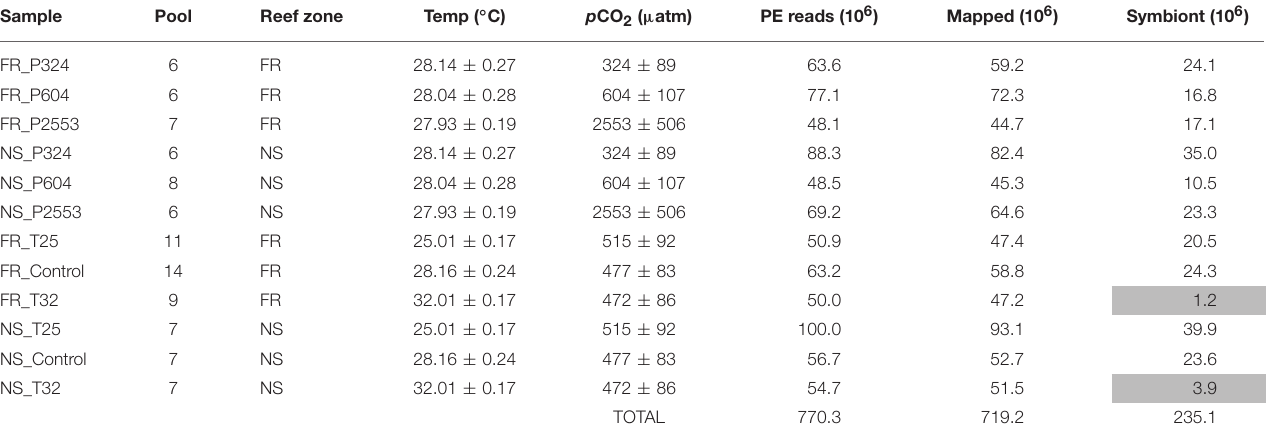
Shaded samples were excluded from analyses due to low read counts arising from low RNA yields, resulting in the availability of 235.1 million reads for downstream